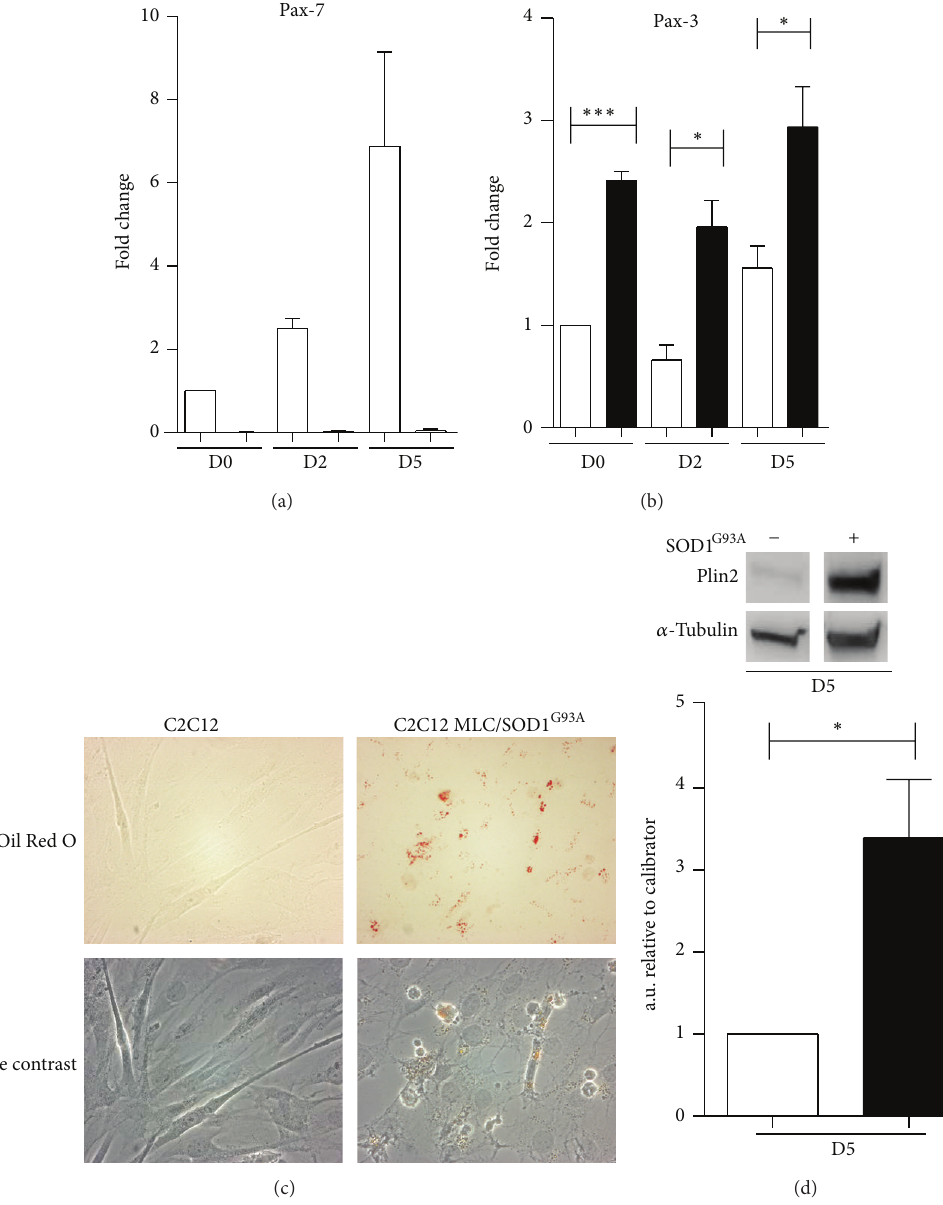
Figure 5: C2C12 MLC/SOD 1 G 93 A cells exhibit adipogenic features. Real time PCR analysis for Pax7 (a) and Pax3 (b). (c) Upper panel shows Oil Red O staining and phase contrast of control C2C12 and C2C12 MLC/SOD 1 G 93 A transfected cells at day 5 in culture. (d) Upper panel shows representative western blot analysis of Plin2 and relative densitometric analysis (lower panel) of the ratio between Plin2 and 𝛼 -tubulin in C2C12 (white bars) and C2C12 MLC/SOD 1 G 93 A (black bars). D0, D2, and D5 referred to days of culture in differentiation condition. Data are represented as mean ± SEM ( ∗ 𝑃 < 0.05 ; ∗∗∗ 𝑃 < 0.0005